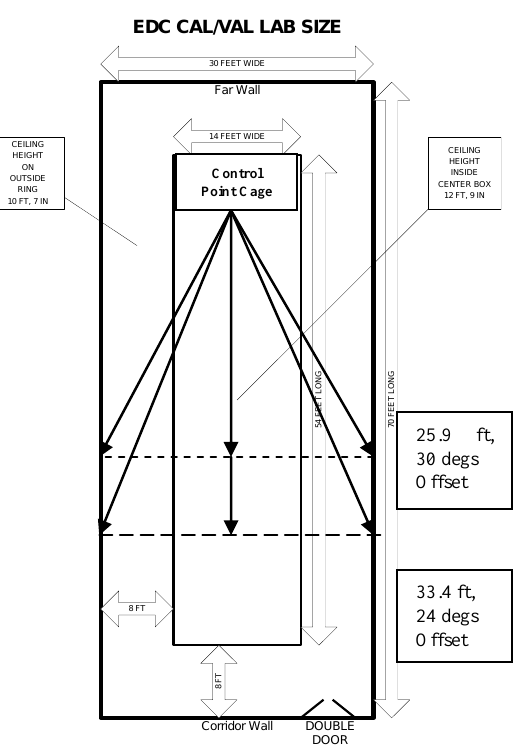
Figure 1. Layout of the calibration lab and the calibration cage The camera calibration facility is located at the USGS’s Earth Resources Observation and Science (EROS) Data Center in Sioux Falls, South Dakota. Fig. 1 shows the position of the calibration cage, with respect to the room. Also shown are some of the positions for locating the cameras. The cage consists of three parallel panels. Each panel has a number of circular retro- reflective targets (dots), and a few coded targets (Fig 2a). The coded targets are so referred because the pattern of the placement of the individual circular dots that make up these targets is unique (Fig. 2b). Each coded target has five dots that are positioned in the same relative orientation as the red lines shown in Fig. 2(b). The intersection of the red lines is taken as the centre of the coded target.